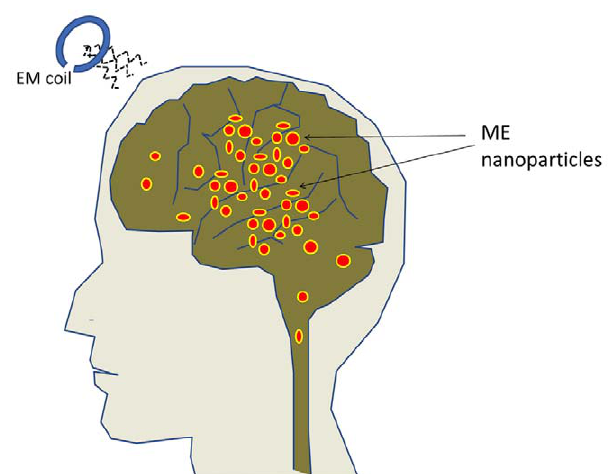
Figure 1. Illustration of the deep brain stimulation approach. Illustration of the deep brain stimulation approach.